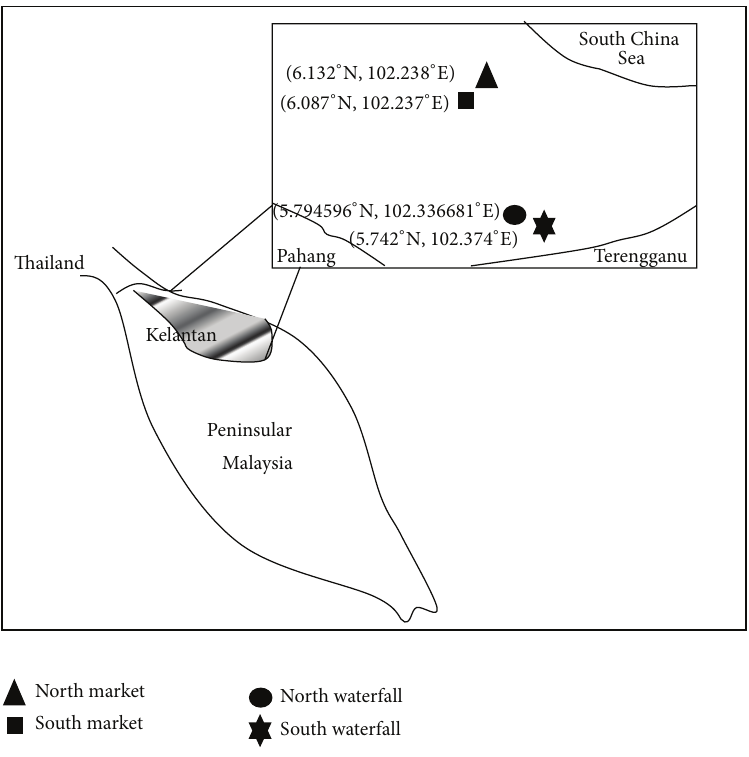
Figure 1: Location of sampling sites in north-eastern state of